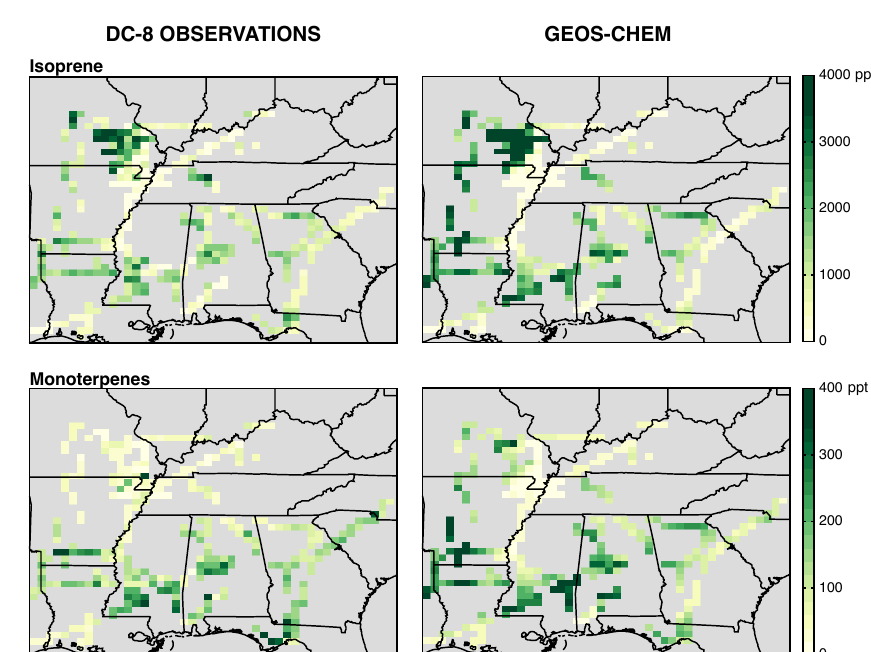
Figure 4. Observed (left) and simulated (right) mixing ratios of isoprene and monoterpenes below 1km during the SEAC 4 RS aircraft campaign (12 August–23 September 2013). The GEOS-Chem model has been sampled along the aircraft flight tracks, and the observations binned to the spatial and temporal resolution of the model. The normalized mean bias of the simulation relative to the PTR-MS measurements in the lowest 500m is + 34% for isoprene and + 3% for